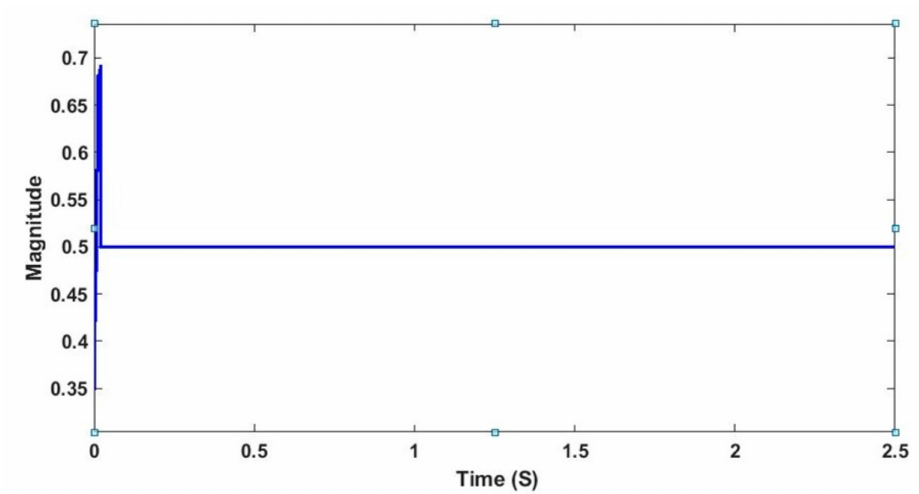
Figure 19. The response of the fuzzy logic